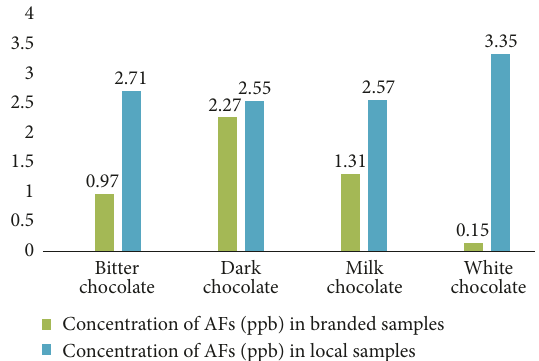
Figure 3: HPLC chromatogram of branded chocolate sample.